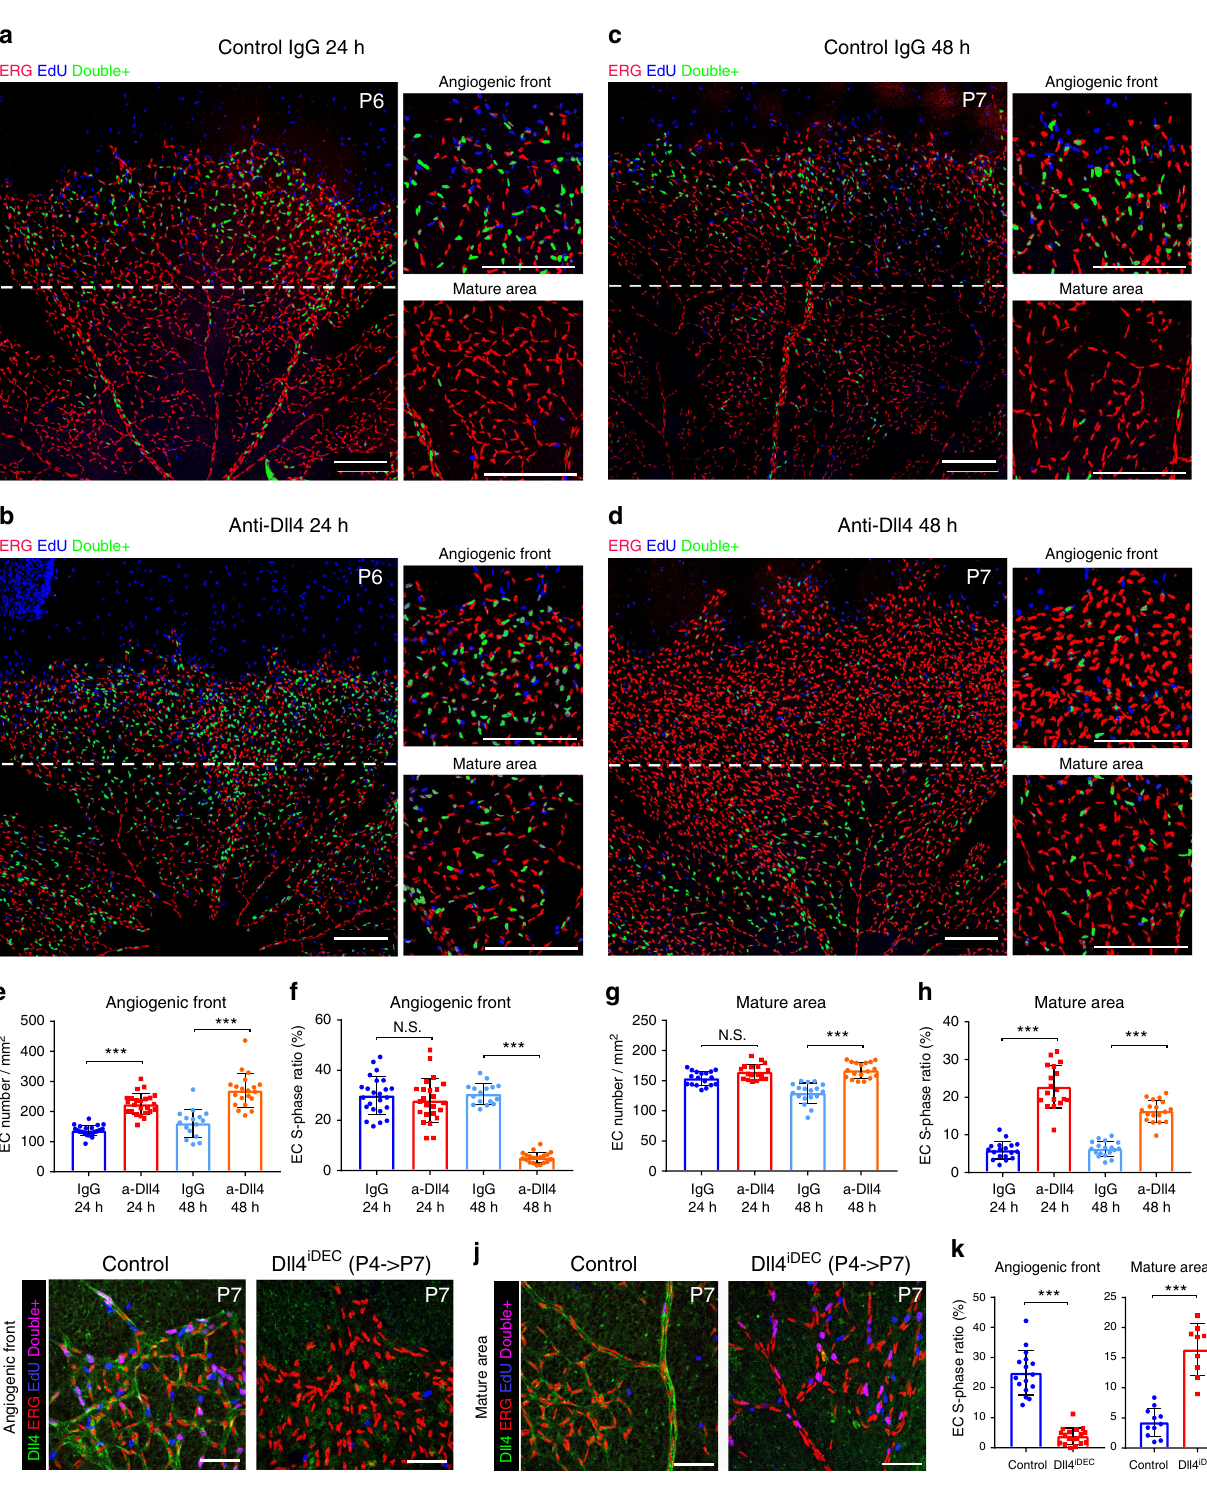
Fig. 2 Dll4/Notch signalling inhibition induces context-dependent proliferative effects. a – d Confocal micrographs of the postnatal retinal vasculature from animals treated at P5 with IgG (control) or anti-Dll4 for 24 h ( a , b ) or 48 h ( c , d ). Anti-Erg (red) labels EC nuclei. EdU labels the nuclei of all cells in S-phase in the previous 4 h. Blue nuclei mark non-endothelial cells in S-phase, and double-positive (Erg + /EdU + ) cell nuclei are pseudocoloured green to better highlight ECs in S-phase. Scale bars, 200 μ m. e – h Comparison of indicated parameters in large microscopic fi elds of antibody treated retinas ( n = 4 mice per group). Inhibition of Dll4/Notch signalling with anti-Dll4 leads to fast (24 and 48 h) endothelial expansion (number of Erg + cells per fi eld) followed by premature cell-cycle exit at the angiogenic front ( e , f ) and cell-cycle re-entry by mature ECs ( g – h ), which are indicated by the changes observed in the frequency of Erg + cells in S-phase (EdU + ). i , j EC-speci fi c deletion of the Dll4 gene from P4 to P7, results in a similar proliferative response. Scale bars, 70 μ m. k Comparison of indicated parameters in large microscopic fi elds of control ( n = 3) and mutant ( n = 3) mice retinas. Error bars indicate std.